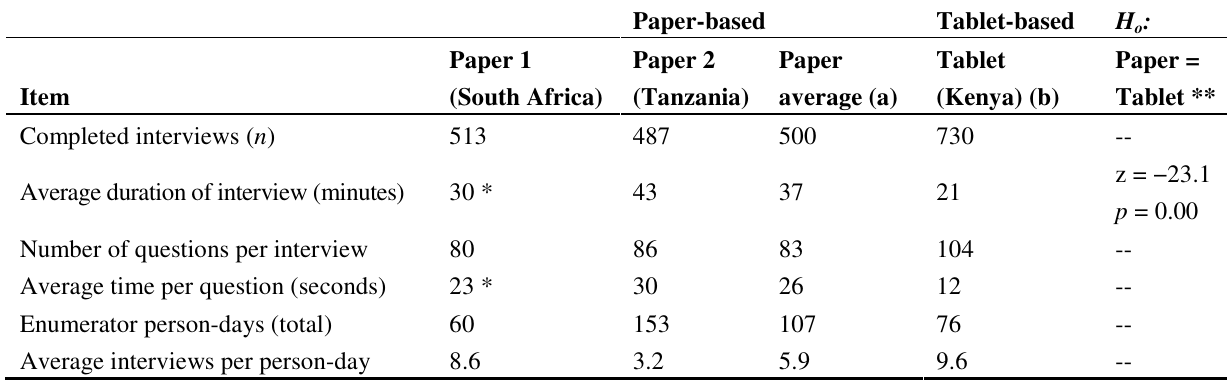
Table 2. Survey characteristics detailing the n for each survey, the average duration of interview, number of questions per interview, and other relevant